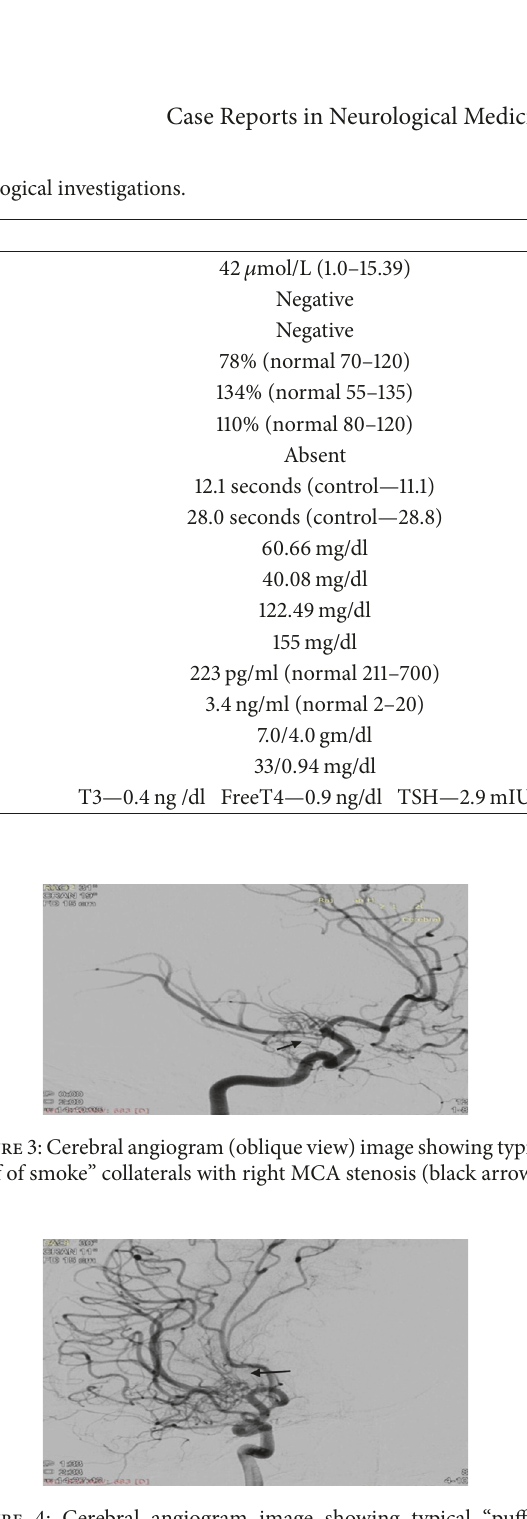
Figure 4: Cerebral angiogram image showing typical “puff of smoke” moyamoya collaterals (black